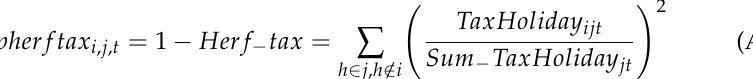
Robust standard errors in parentheses, clustered at the firm level. All regressions include firm fixed effects